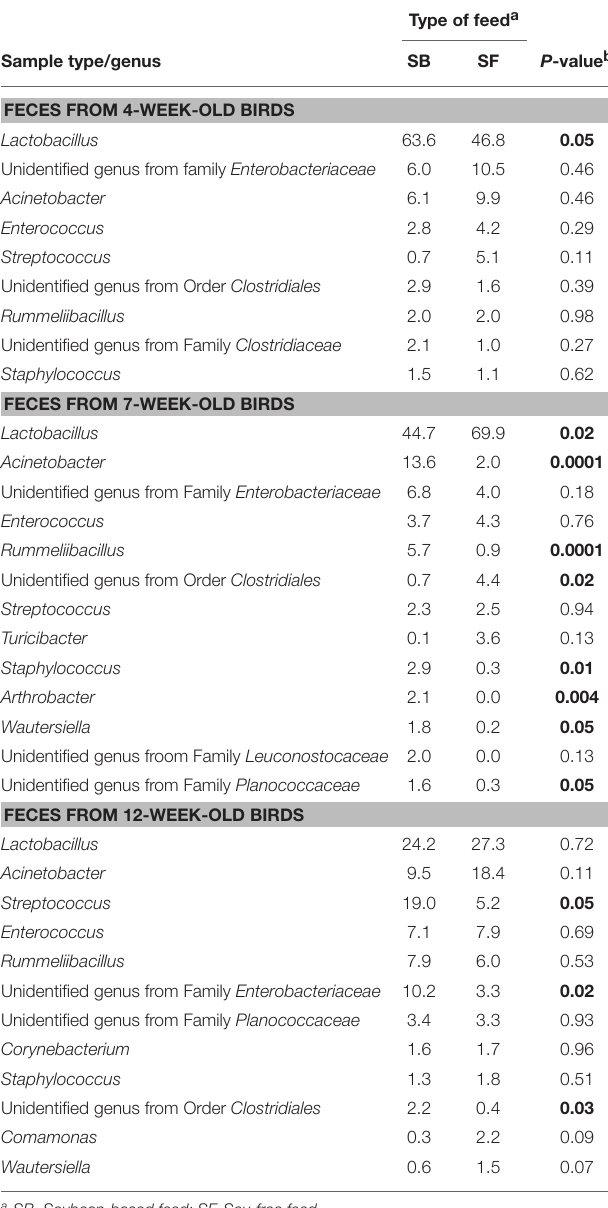
TABLE 3 | Relative abundance of major bacterial genera ( ≥ 1% of all OTUs recovered) for pasture-raised broilers fed soybean or soy-free diets at different stages along the farm-to-fork continuum: fecal samples from 4, 7, and 12-week-old broilers.